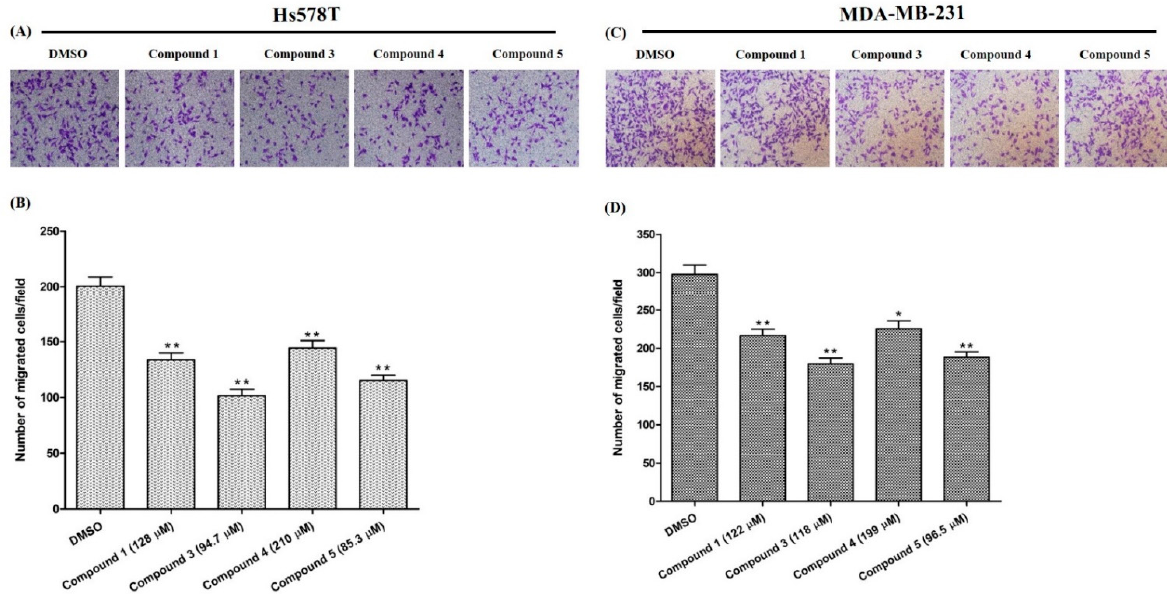
Figure 4. Attenuation of TNBC cell migration. ( A ) and ( C ): visualized migrated cells after treating with compounds. ( B ) and ( D ): the migrated cells stained with crystal violet, and photographs taken for the inhibition calculation. The results are presented as the mean ± SD of three independent experiments. Bars with asterisks indicate significant differences from the control at p ≤ 0.05 (*) or p ≤ 0.01 (**).